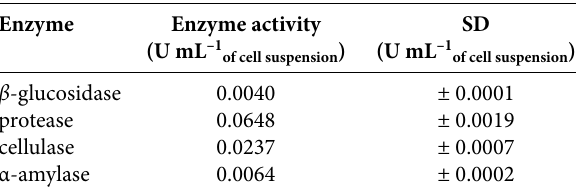
Table 5 : Initial activity of various enzymes in the P. triangularis cell suspension before homogenization and standard deviation of meas- urements (SD).